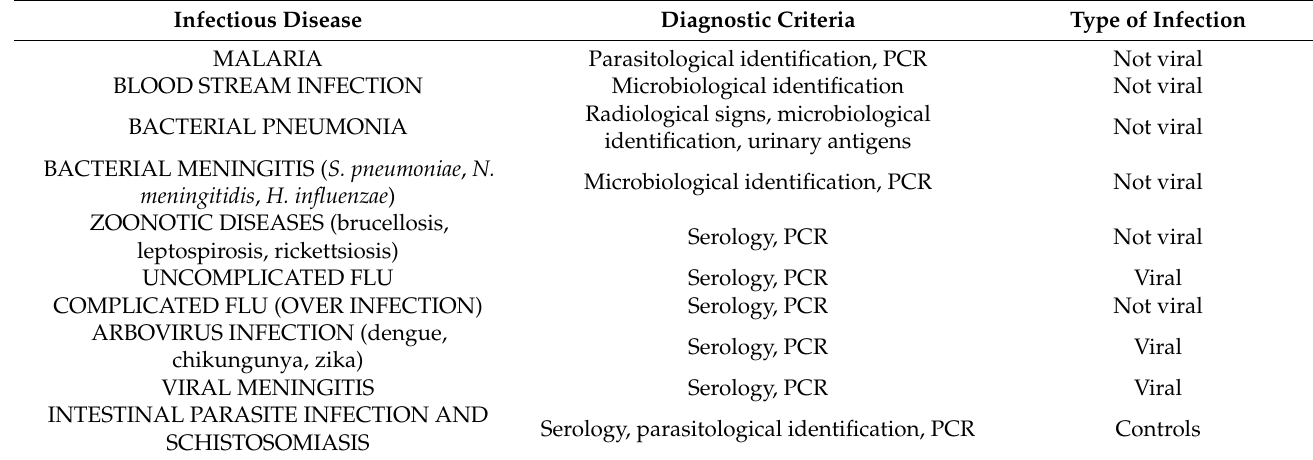
Table 1. Causes of fever and